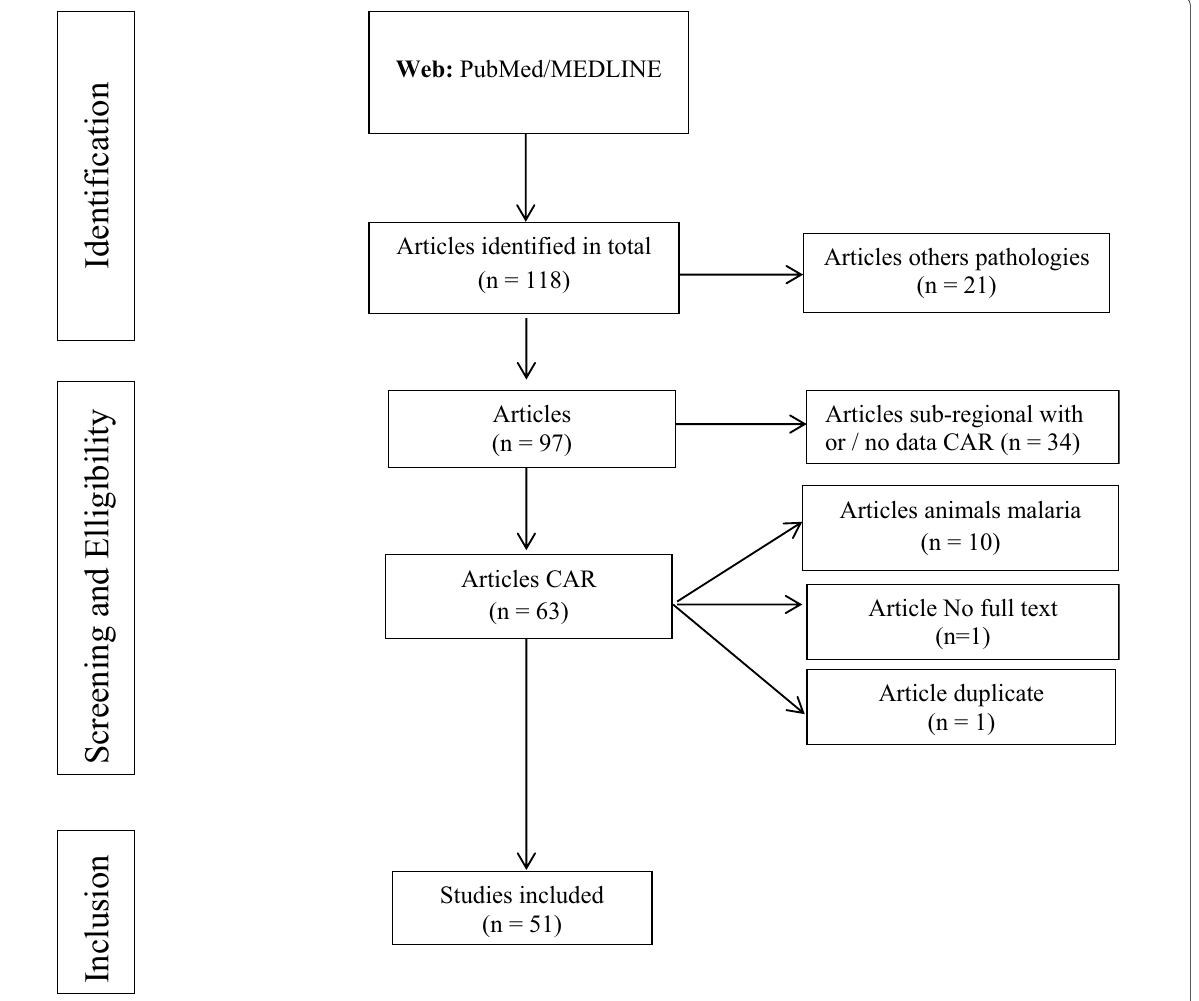
Fig. 1 Flowchart of study selection process and search